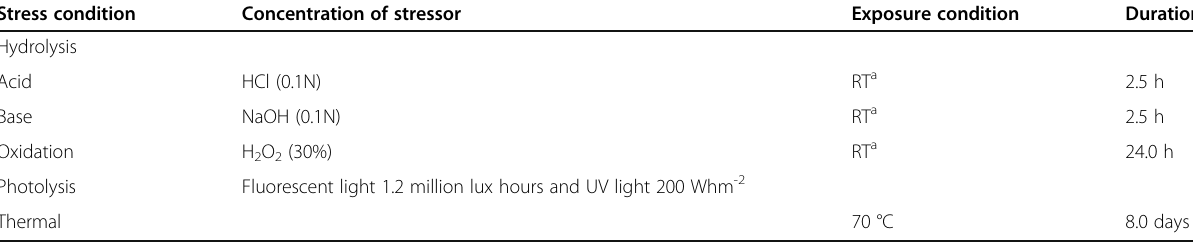
Table 1 Optimized stress conditions for degradation of febantel Stress condition Concentration of